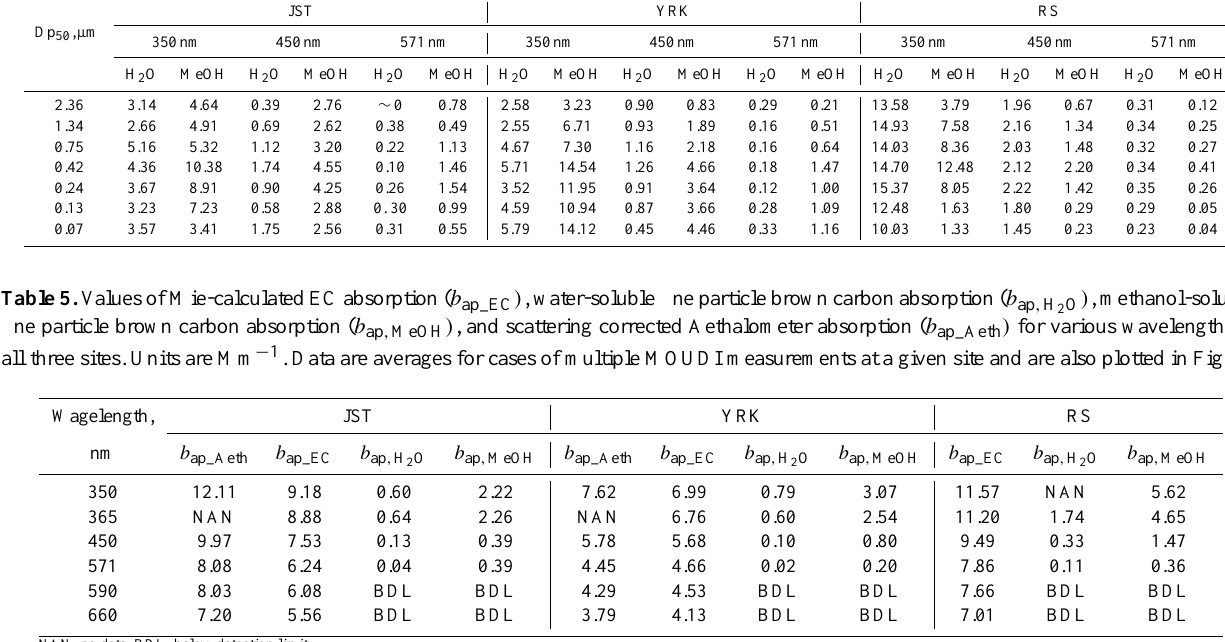
Table 4. Derived absorbing component of the complex refractive index ( k) of brown carbon from MOUDI substrates extracted in water or methanol (H 2 O_Abs( λ) or MeOH_Abs( λ)) . Tabulated values are k × 10 3 . Note that these refractive indices are assuming externally mixed aerosols composed of only WSOC or OC, i.e., they are calculated using WSOC and OC mass, see Eqs. (6) and (7). Dp 50 ,µm